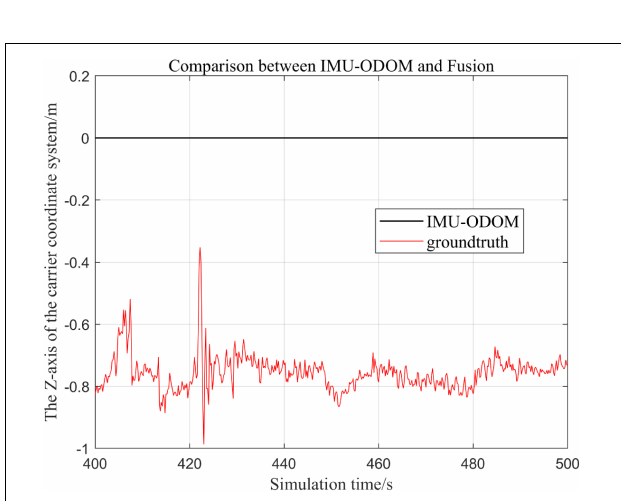
FIGURE 15 | Comparison of the overall trajectory in the x -axis after VIO failure and when all sensors are working normally.